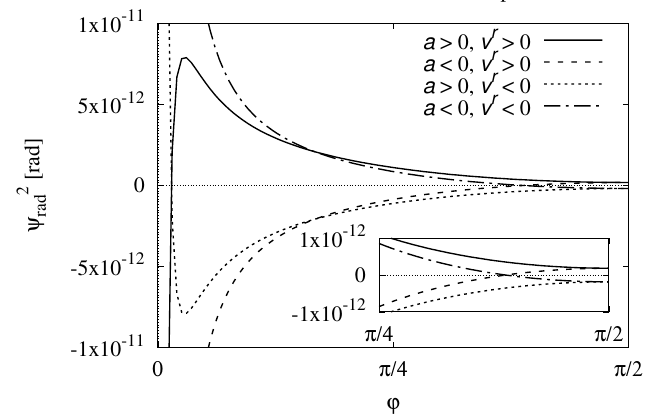
Figure 5. φ dependence of Equation